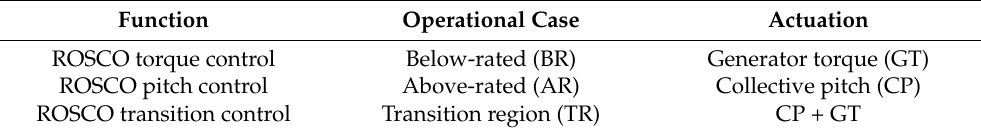
Table 2. Controller strategies for the IEA wind 15 MW wind–wave basin experimental